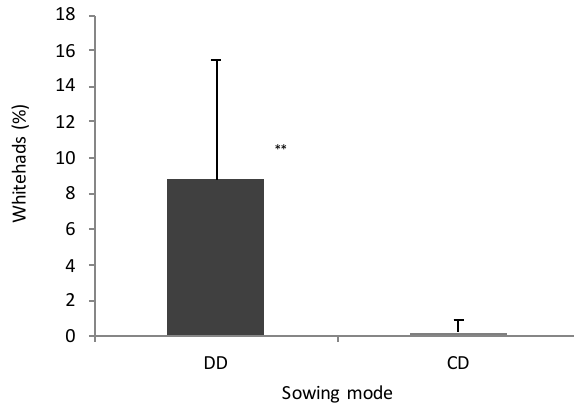
Figure 2. Mean incidence of Fusarium pseudograminearum stem base and root infections resulting from different cereal sowing methods (DD vs CD) for durum wheat, oat of barley during three growing seasons. Error bars are 2 × standard deviations. NS: No significant difference ( P > 0.05). *: significant difference ( P < 0.05).